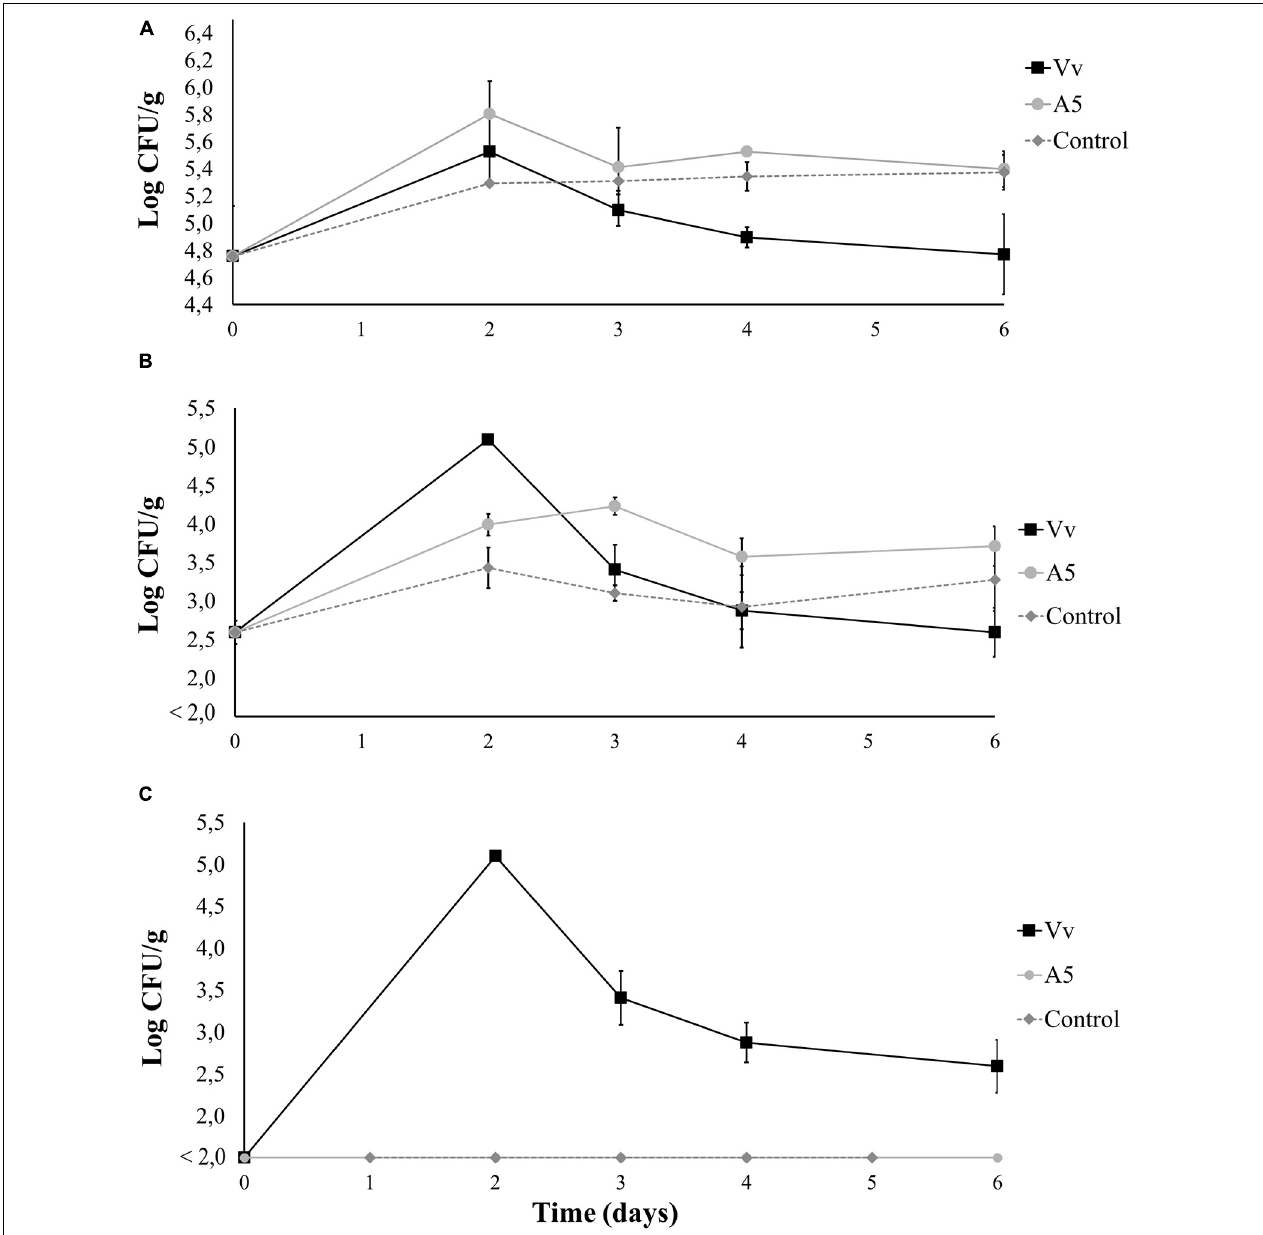
FIGURE 4 | Total aerobic bacteria (A) , total vibrio (B) , and Vibrio vulnificus (C) levels in oysters from bioassay 1 (evaluation of colonization potential). Three treatments are shown: Vv inoculated with V. vulnificus only ( (cid:4) ), A5 inoculated with A5 only ( • ), and control ( (cid:7) dotted line). The absence of colonies is represented as below the limit of detection (LOD) ( < 2.0 log